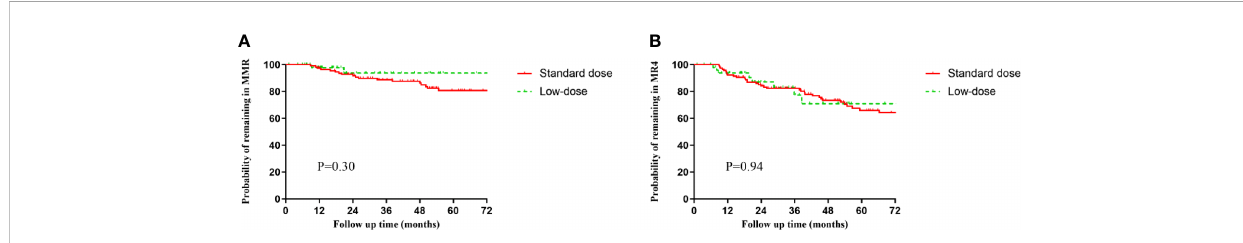
FIGURE 2 Molecular relapse-free survival (MRFS) of major molecular response (MMR) ( BCR-ABL1 IS ≤ 0.1%) or MR4 ( BCR-ABL1 IS ≤ 0.01%) in the standard-dose and low-dose groups. (A) MMR. (B)